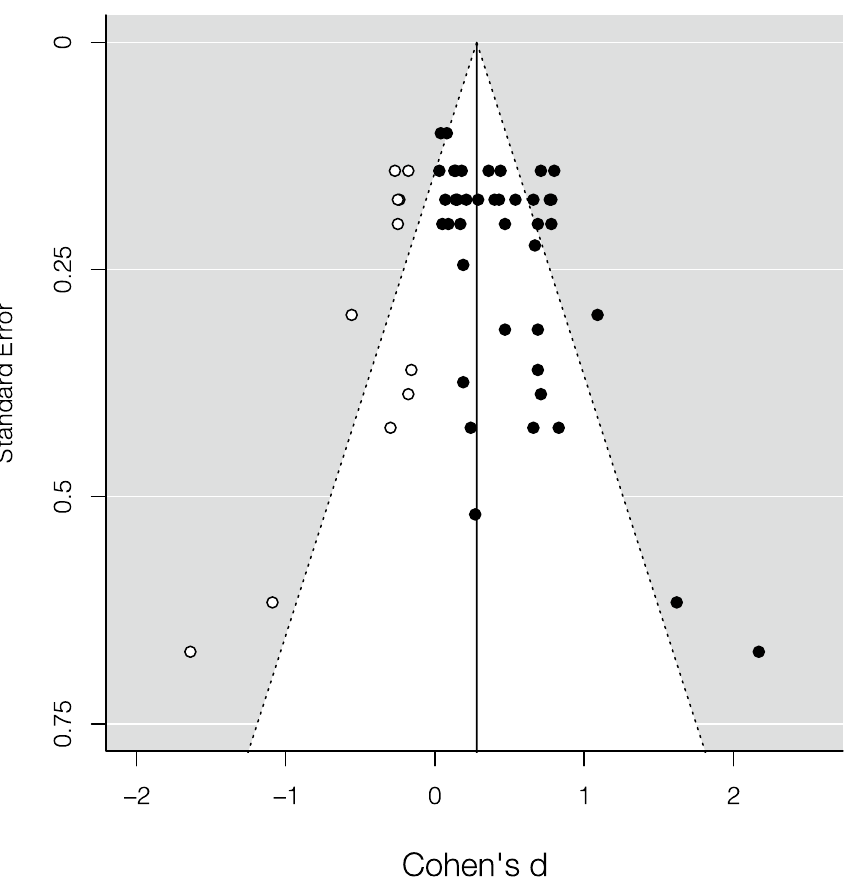
Figure 5. Funnel plot of the studies that used RTs as main dependent variable included in the meta-analysis. Black dots represent the studies included, while white dots represent hypothetical missing studies on the left side (estimated using the trim and fill method). The vertical line represents the corrected effect size.